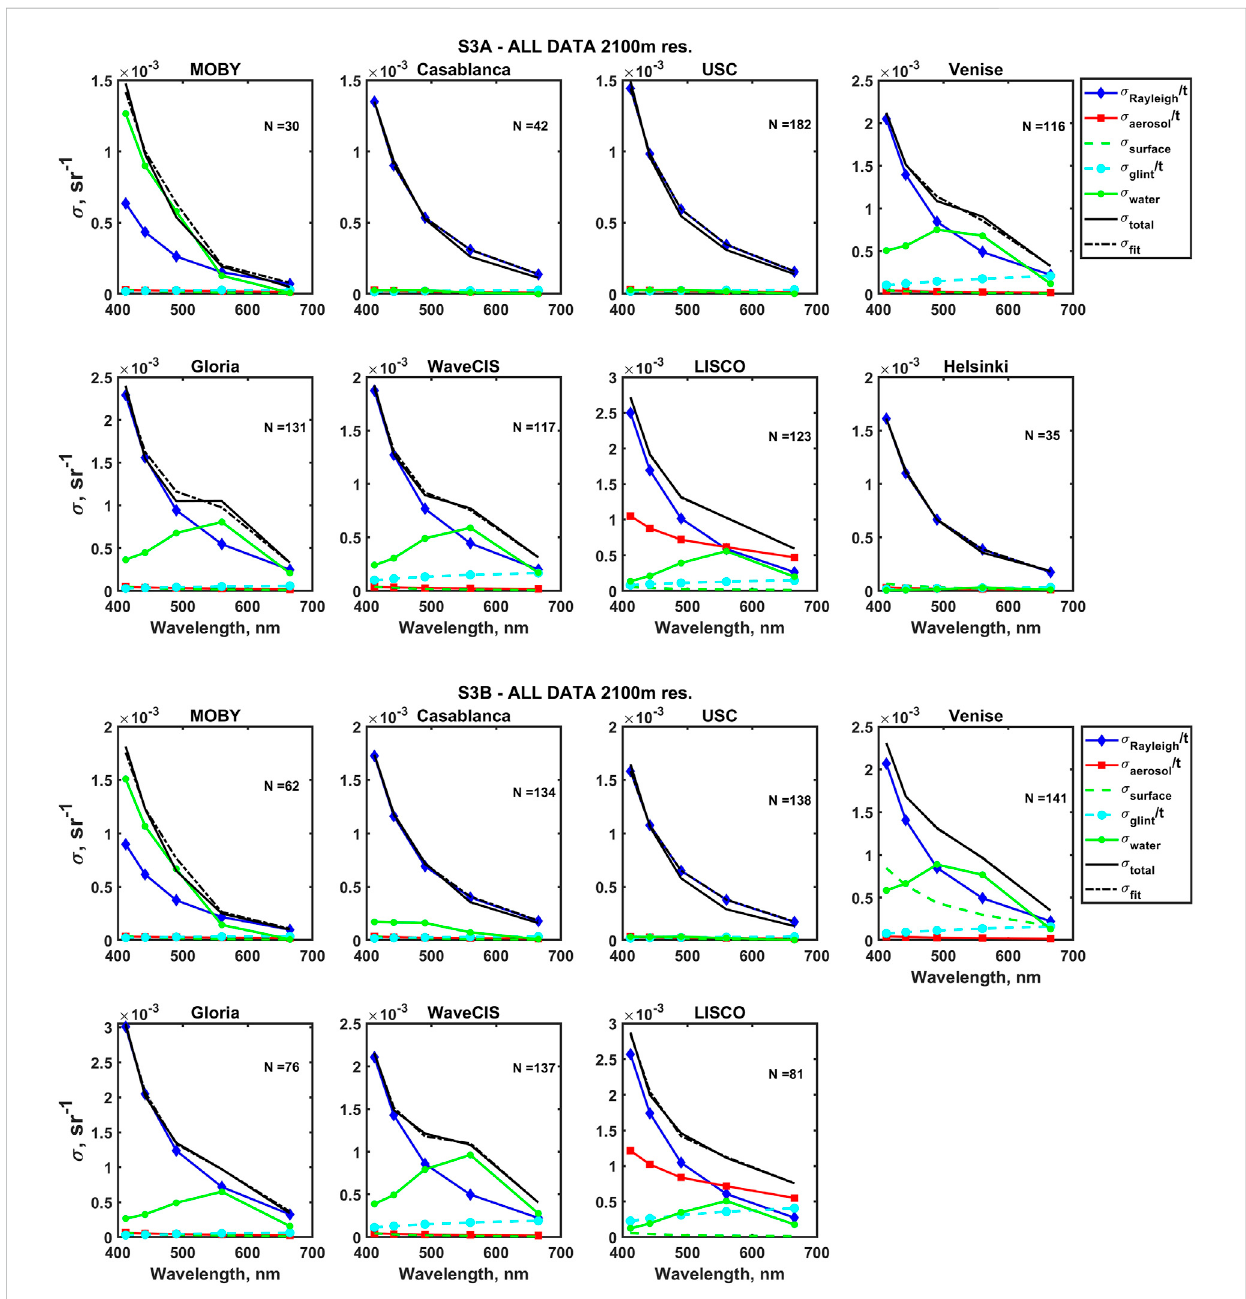
FIGURE 4 Results of fi tting for all areas of study for OLCI S3A and S3B. Total uncertainty is the solid black line, and the fi tted curve is dashed black